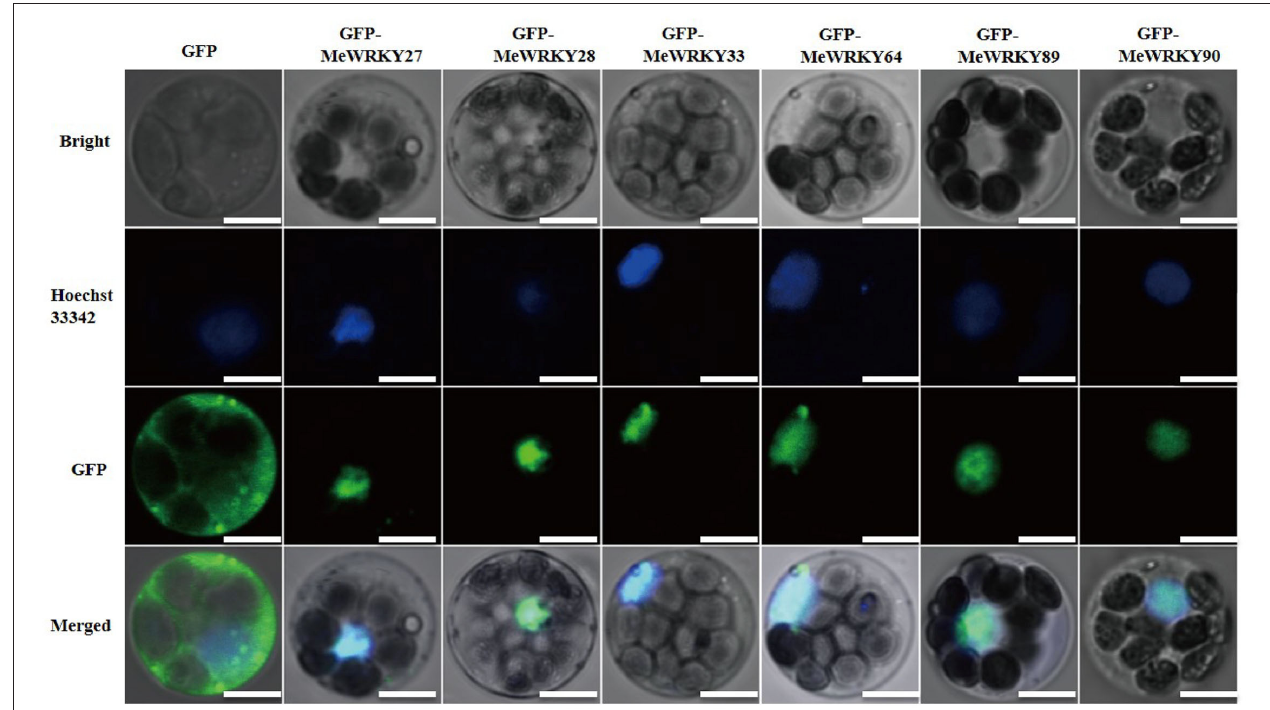
FIGURE 3 | Subcellular localization of MeWRKY IIas in cassava protoplast. The cell nucleus was stained with Hoechst 33342. GFP alone serves as a negative control. Bar = 5 µ